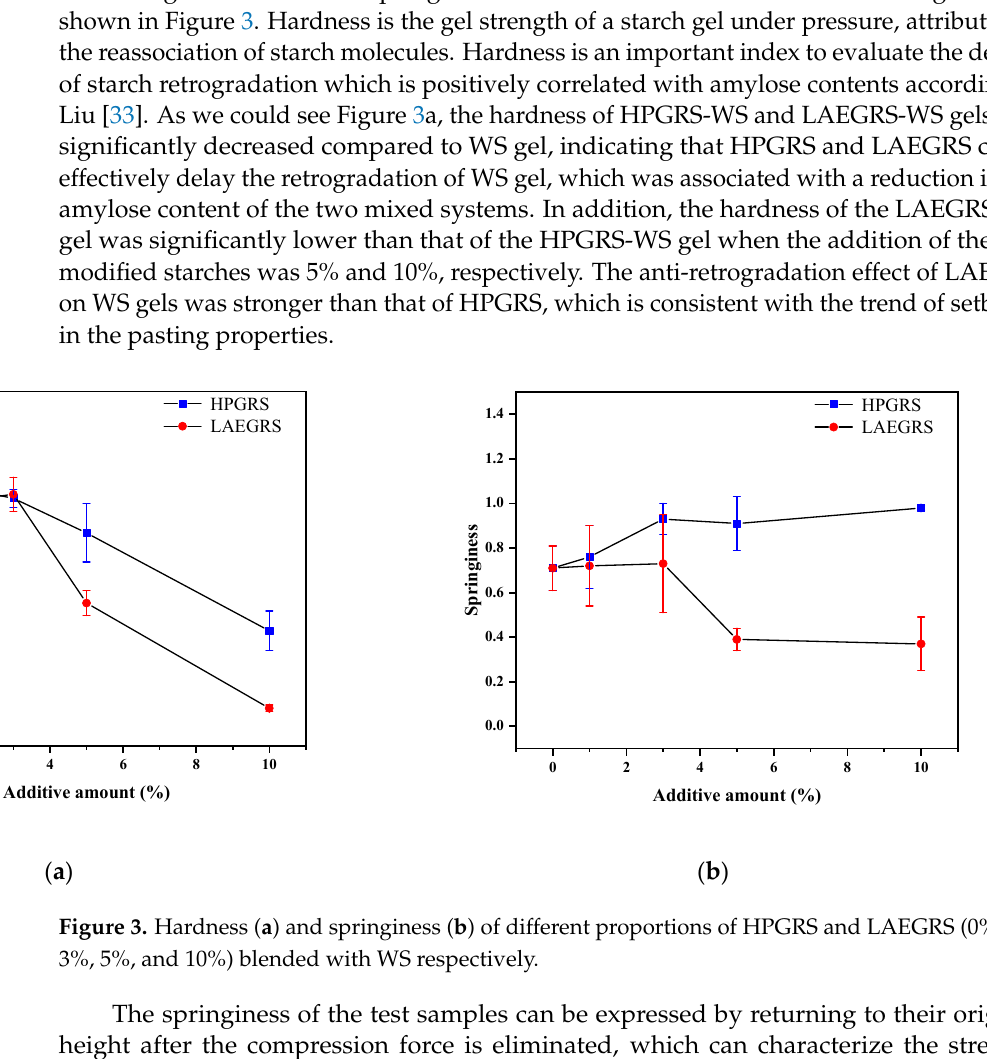
Table 3. T 2 relaxation distributions and factions of signal amplitude of protons of different propor- tions of HPGRS and LAEGRS (0%, 1%, 3%, 5%, and 10%) blended with WS respectively. HPGRS-WS Samples